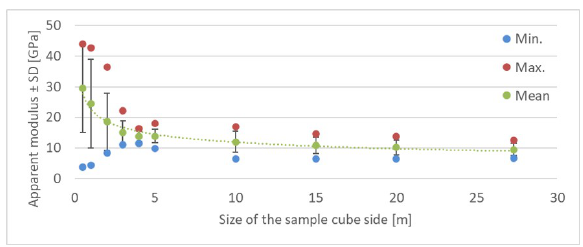
Figure 3. Apparent deformation moduli – y axis.